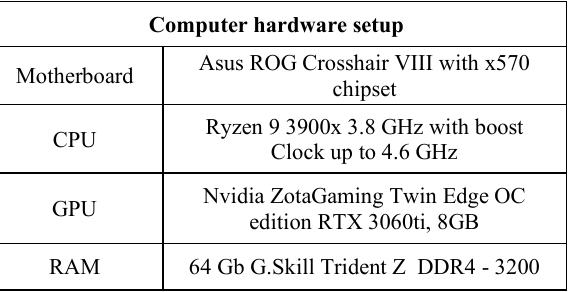
Table 2 . Hardware configuration for point cloud elaboration.